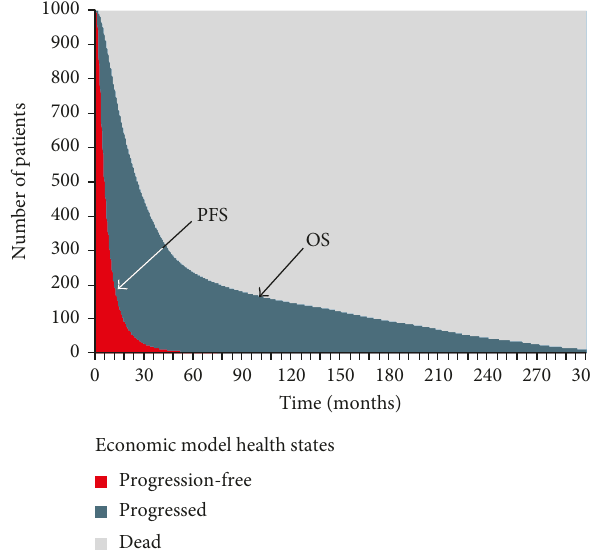
Figure 1: Economic model structure. OS PFS progression-free survival curve. Note that the PFS and OS (cid:31) curves shown are illustrative